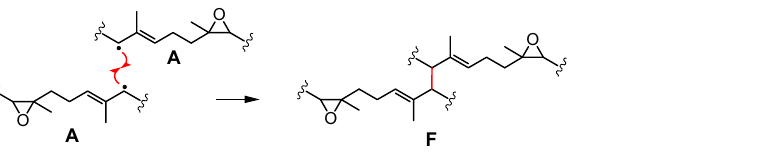
Figure 6. Proposed crosslink mechanism under UV irradiation of the ENR/M-CNC nanocomposites.